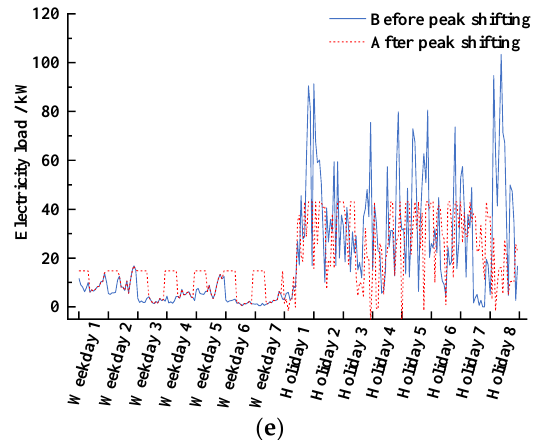
Figure 11. Peak-load changes of the home hotel cluster during the Spring Festival holidays and seven days before the holiday before and after peak shifting: ( a ) user 1; ( b ) user 2; ( c ) user 3; ( d ) user 4; ( e ) user